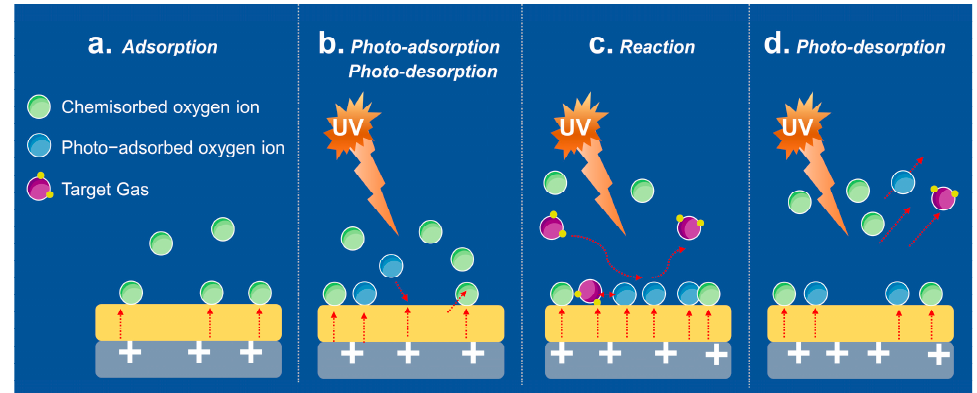
Figure 5. Photo-activated gas-sensing mechanism under UV irradiation.